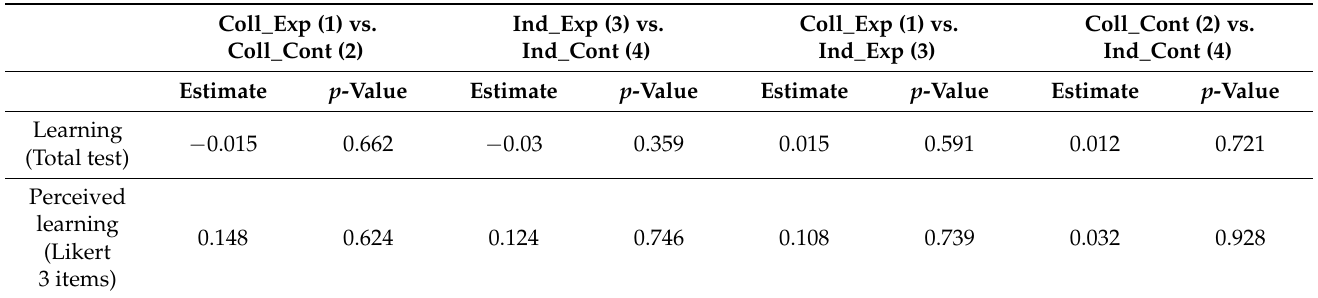
Table 5. Impact of immersion and collectivity on learning